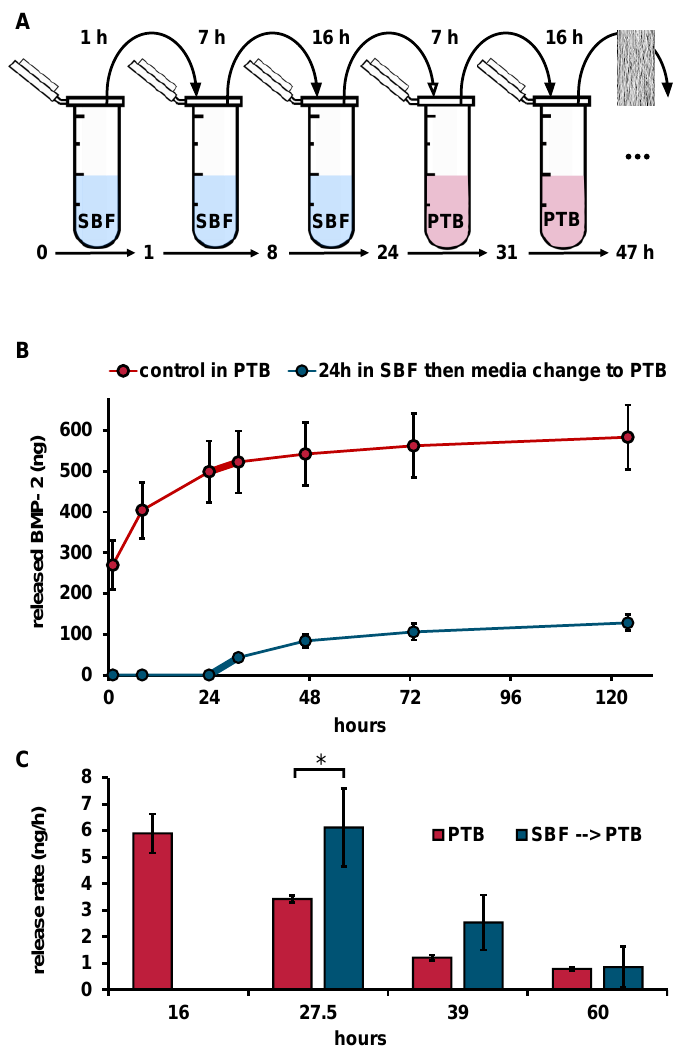
Figure 4. ( A ) Illustration of the release experiment with change of medium type. ( B ) Released BMP-2 (ELISA) from implant prototypes over time with and without medium switch ( n = 3), thicker connection line highlights first release period after medium switch. ( C ) Release rates with and without medium switch ( n = 3). Implant prototype mass: 10 mg each, error bars indicate SD between single release experiments. Statistics was performed using one sided t-test with the level of significance set at p ≤ 0.05 (* ≤